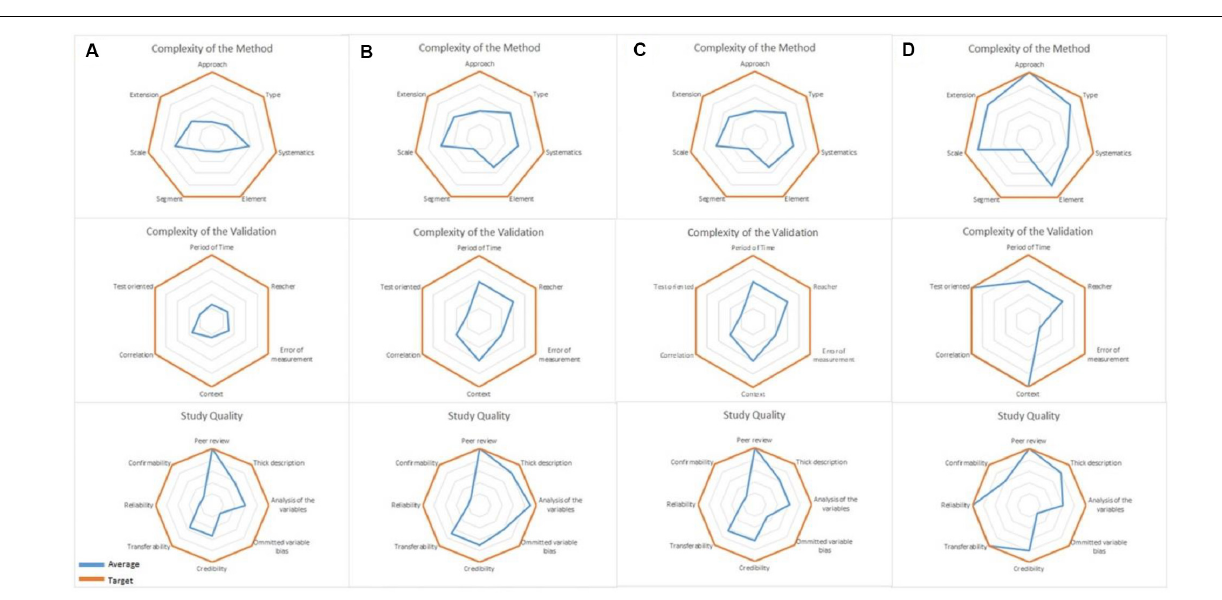
subject to checks and controls, including a peer review. Most